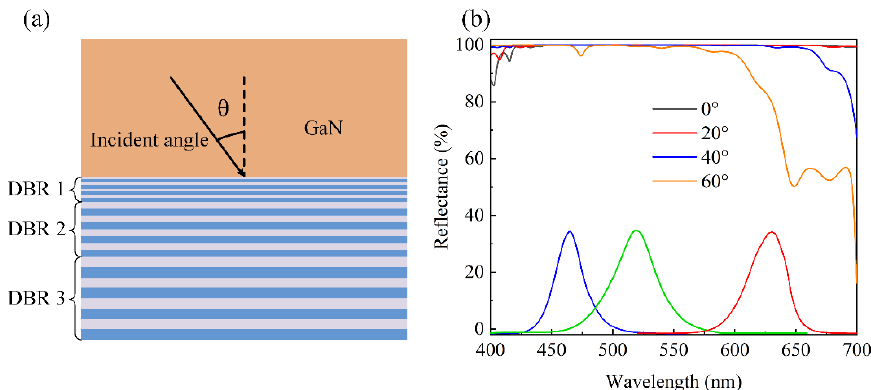
Figure 3. ( a ) Schematic illustration of DBR III structure. ( b ) Reflectance spectra of the DBR III as a function of incident angle.